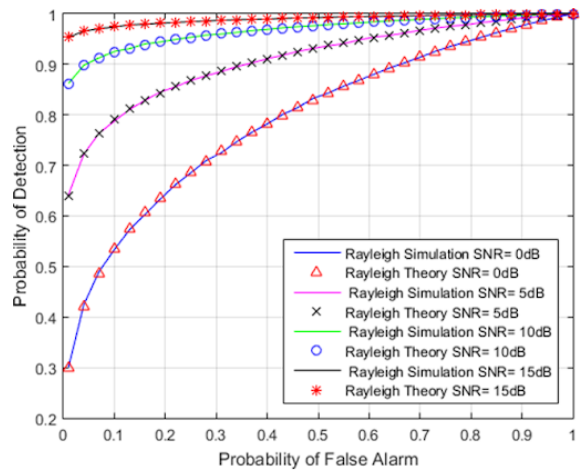
Figure 4. P D versus P F of fading channel (Rayleigh)